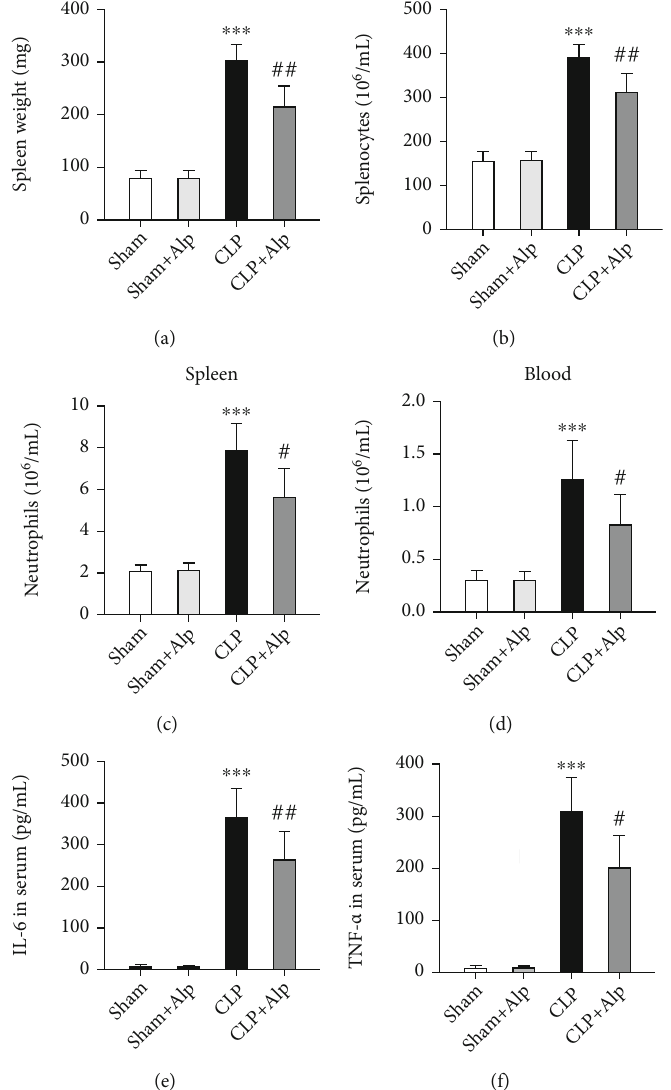
Figure 2: E ff ects of alpinetin on splenic myelopoiesis and leukocytosis eight days after the procedure. The spleen and blood were collected and analyzed eight days after the cecal ligation and puncture (CLP) operation. (a) Weight, (b) total number of WBCs, (c) neutrophils in the spleen, and (d) neutrophils in the blood. (e) IL-6 and (f) TNF- α in serum were quanti fi ed by using ELISA kits. Sham ( n = 10 ), sham+Alp ( n = 10 ), CLP ( n = 6 ), and CLP+Alp ( n = 8 ). Data are shown as mean ± SD . ∗∗∗ p < 0 : 001 , CLP vs. sham; # p < 0 : 05 , ## p < 0 : 01 , CLP-Alp vs.